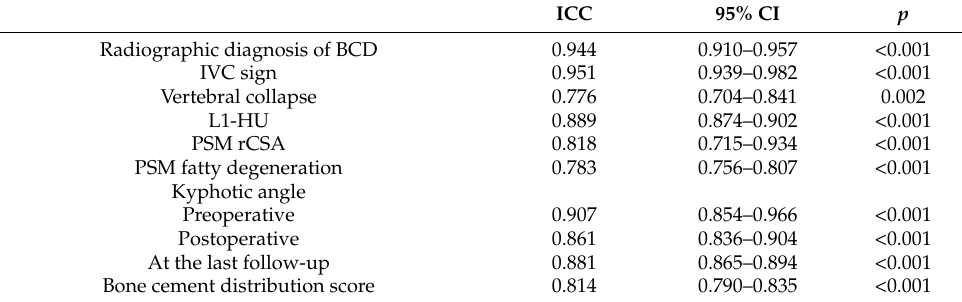
Figure 6. The proportion of fractured levels in the symptomatic, asymptomatic, and control groups. Table 1. Inter-observer reliability for each